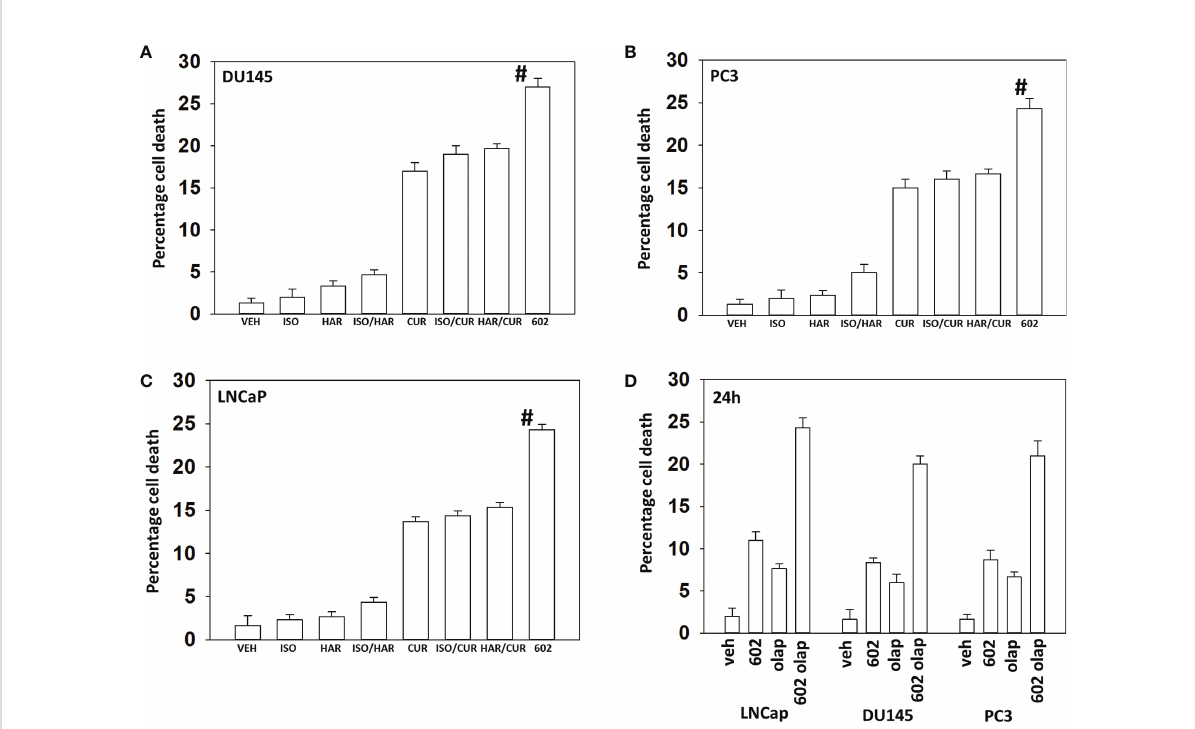
FIGURE 1 GZ17-6.02 interacts with olaparib to kill prostate cancer cells. (A – C) Prostate cancer cells were treated with vehicle control, GZ17-6.02 [curcumin (2.0 m M) + harmine (4.5 m M) + isovanillin (37.2 m M)] or with component parts of GZ17-6.02 as individual agents at the indicated concentrations or in duo combinations. Cells were isolated 48h afterwards and viability determined via trypan blue exclusion assays (n = 3 +/- SD). # p < 0.05 greater than other tested drug treatments. (D) DU145, PC3 and LNCaP prostate cancer cells were treated with vehicle control, GZ17-6.02 (2 m M), olaparib (50 nM) or the drugs in combination for 24h. Cells were isolated, and viability determined by trypan blue exclusion. (n = 3 +/-